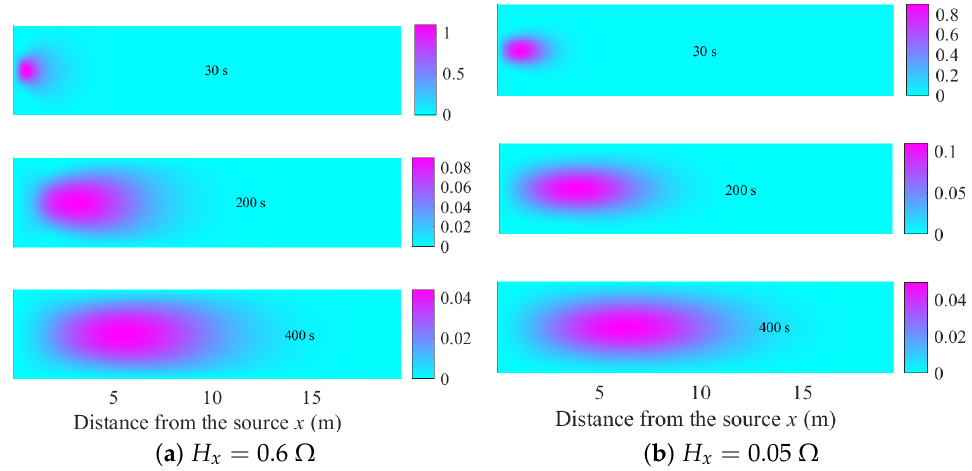
Figure 5. The simulation results of the two-dimensional PDDO-based model (25) with different horizon H x . The weight functions set as k = 3 for Equation (24), other parameters are set as R = 1, v = 0.3 m/s, D = 0.3 m 2